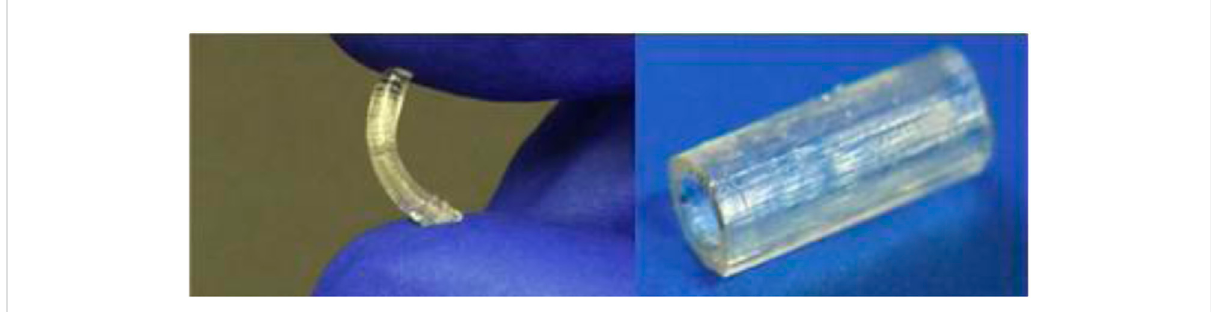
FIGURE 7 MethacrylatedPGSnerveguidanceconduits:theleftiscompressedtohighlighttheelasticproperties,whiletherightshowsthe fi nal3D-printed product ready for implantation (Singh et al.,